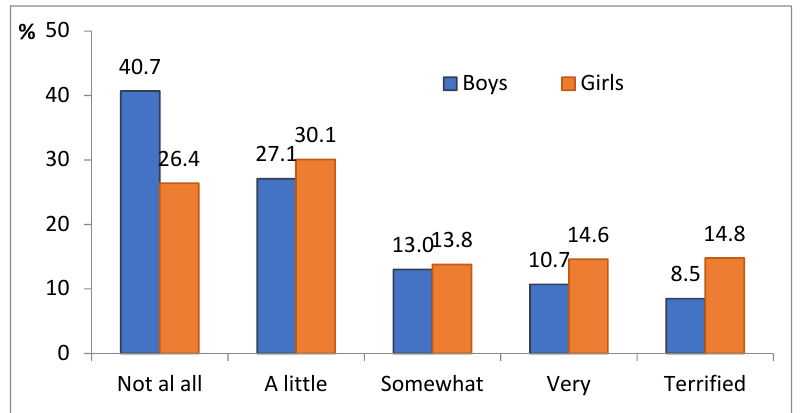
Figure 1. Response rates for boys and girls to the question about how much they were afraid of dental treatment ( χ 2 = 43.0; df = 4; p < 0.001). Table 4. Association of child and adolescent dental fear with gender, age, self-reported health status and tooth brushing habits.